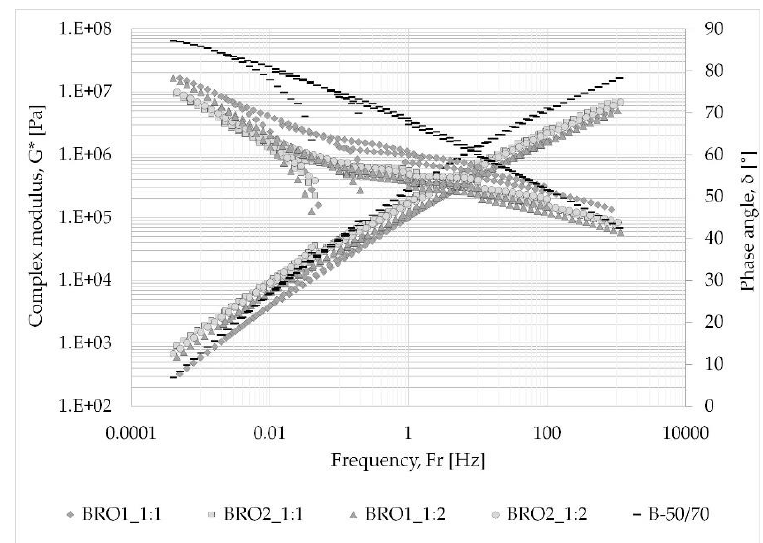
Figure 4. G* and δ master curves of the neat and extended bitumens.